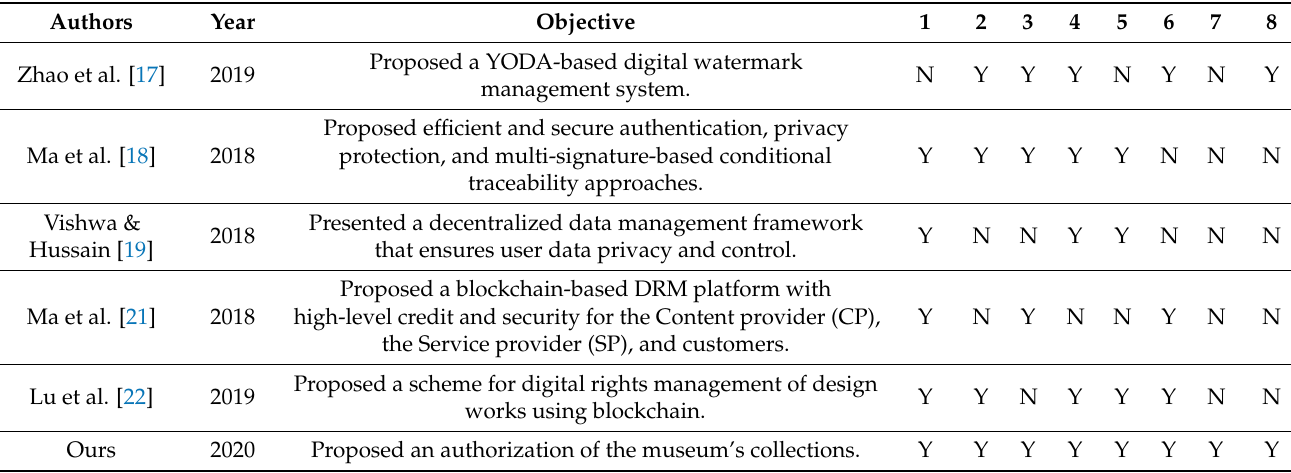
Table 4. Comparison of the proposed and existing digital right management